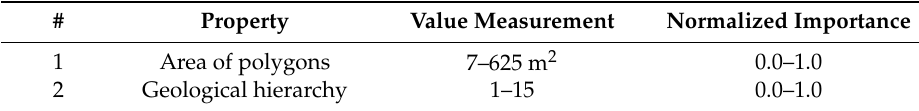
Table 2. Assigning importance values to